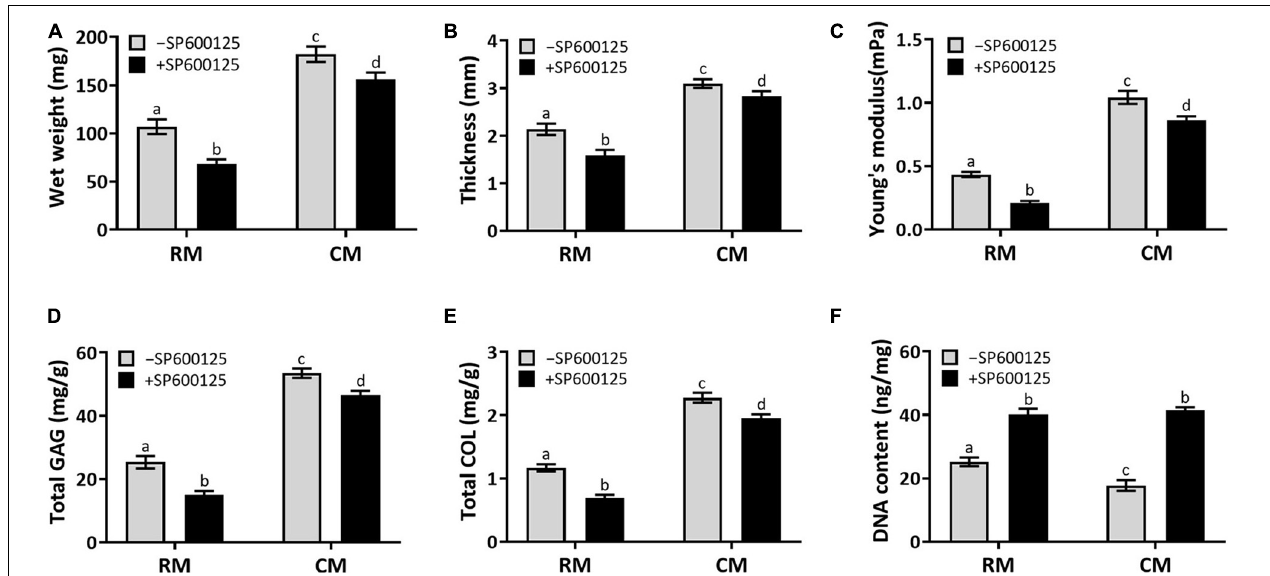
FIGURE 6 | Wet weight, thickness, biomechanical, and biochemical evaluations. Wet weight (A) , thickness (B) , Young’s modulus (C) , total GAG (D) , and total COL (E) contents showed decreasing trends in the RM + SP600125 group compared with the RM-SP600125 group. However, the CM + SP600125 culture reversed these inhibitory effects. Treatment with SP600125 enhanced the DNA contents (F) , which indicates greater cell numbers. More importantly, the CM + SP600125 culture reversed the inhibitory effect of CM on cell survival. Columns with the same letters indicate no statistically significant differences ( p > 0.05), whereas the columns with different letters indicate statistically significant differences ( p < 0.05). ECM, extracellular matrix; RM, regular medium; CM, chondrogenic medium; GAG, glycosaminoglycan; and COL,